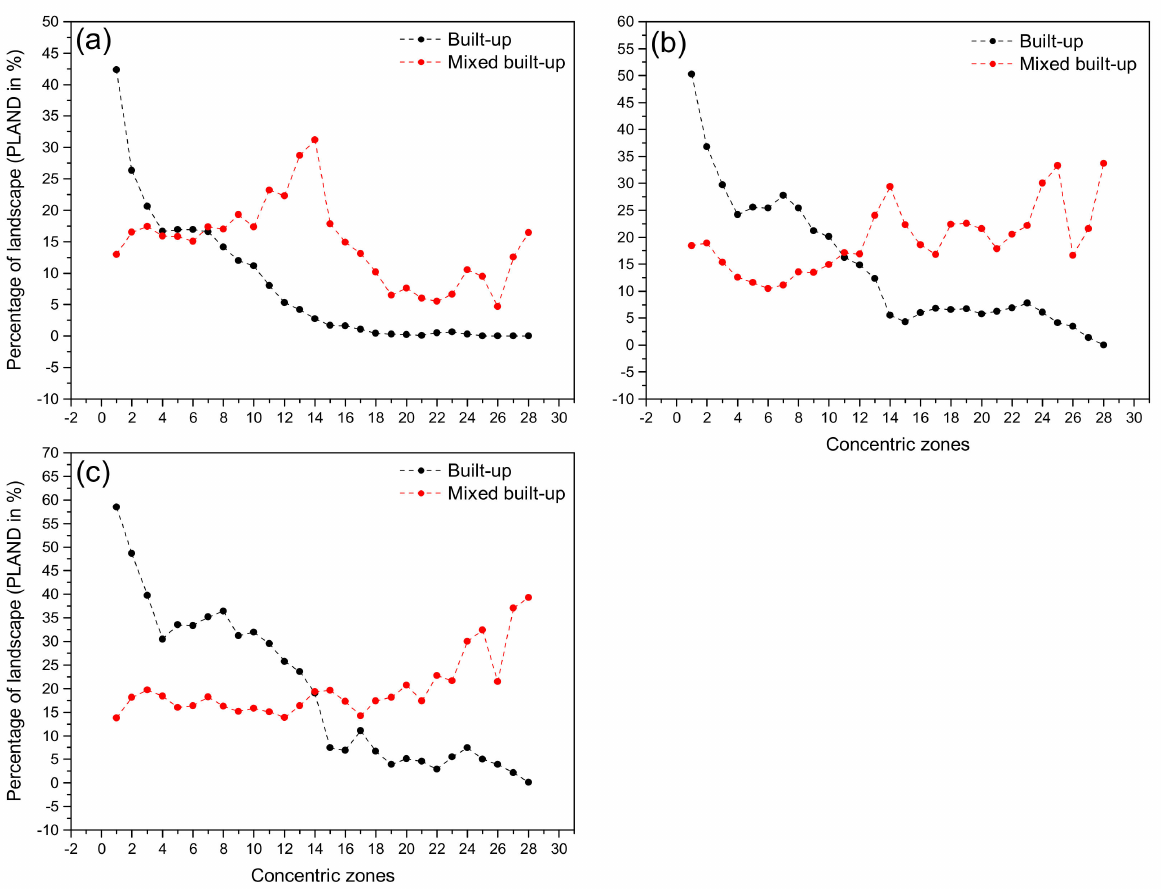
Figure 16. Pattern of the PLAND plotted against the sequential concentric zones of 1 km width each around the river Hooghly within the KMA; the pattern of PLAND of built-up and mixed built-up for the concentric zones in ( a ) 1996, ( b ) 2006, and ( c )